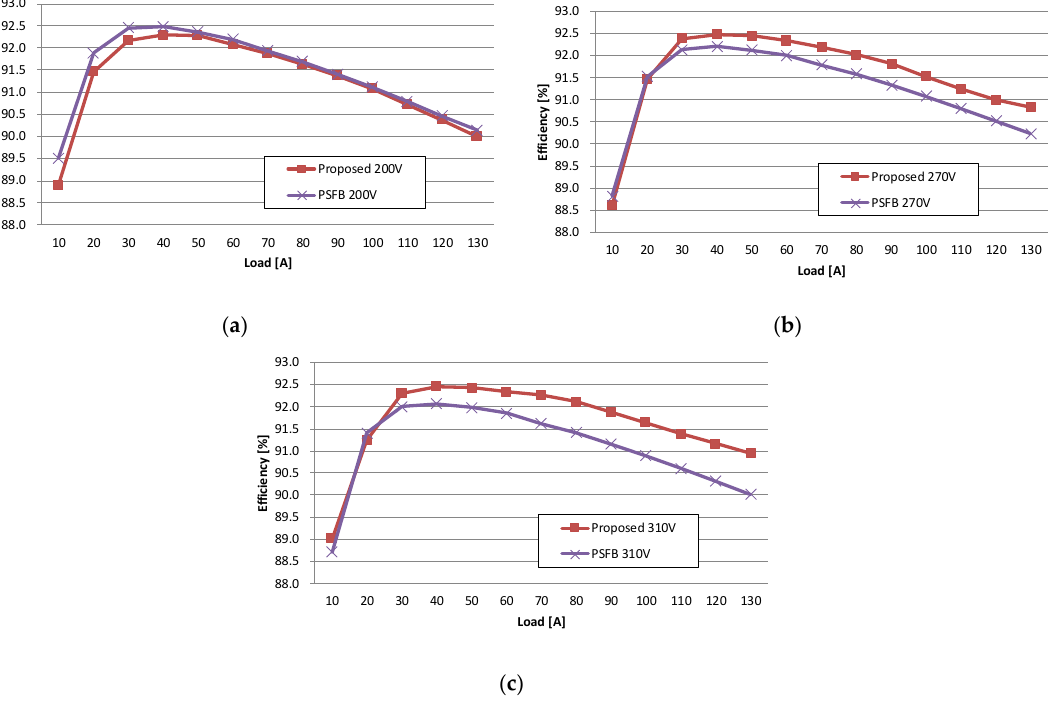
Figure 17. Measured efficiency according to input voltage. ( a ) Minimum input ( V S = 200 V, D = 0.605). ( b ) Nominal input ( V S = 270 V, D = 0.464). ( c ) Maximum input ( V S = 310 V, D = 0.412 ).